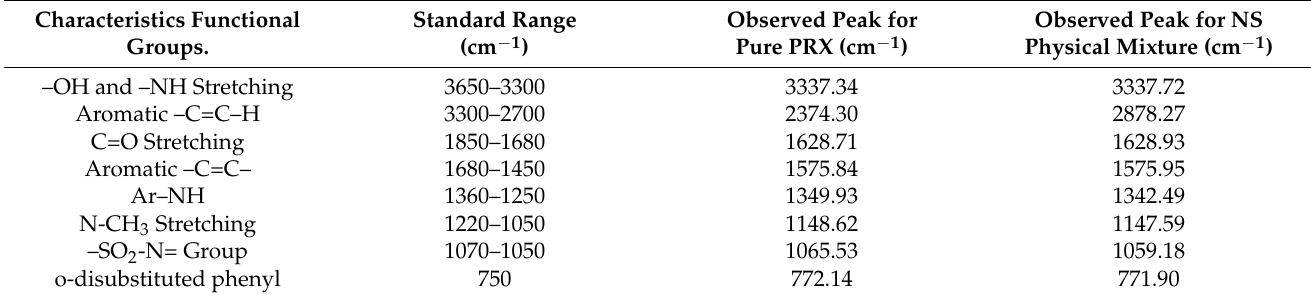
Figure 2. Overlain FT-IR spectra of PRX (A), physical mixture of PRX and PVP K30 ® (B), physical mixture of PRX and Poloxamer 188 ® (C), physical mixture of PRX and mannitol (D), physical mixture of PRX, PVP K30 ® , Poloxamer 188 ® and mannitol (E), and freeze-dried optimized formulation (NS9) (F). Table 5. Interpretation data of the FT-IR spectral